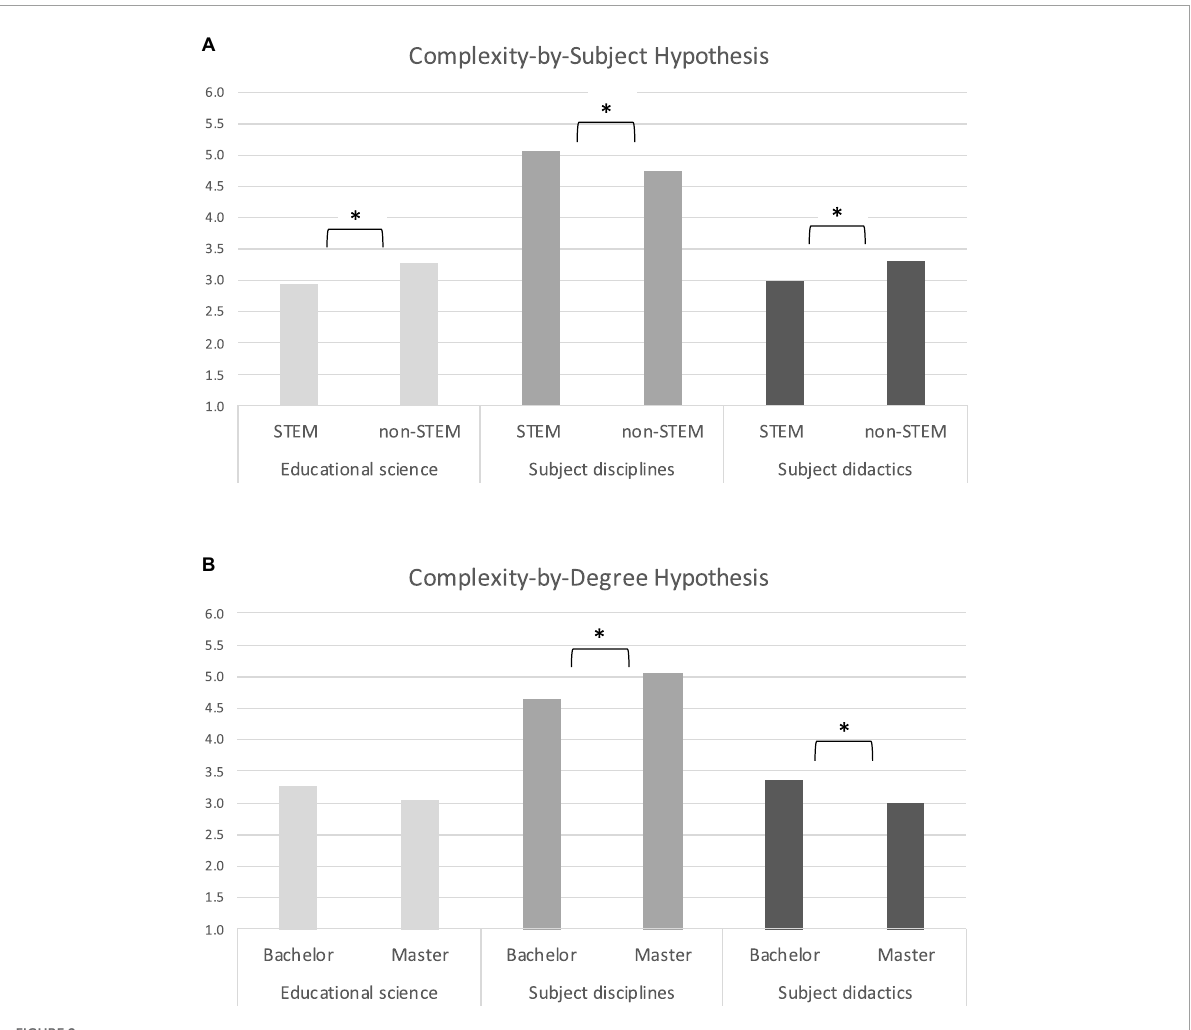
FIGURE2 Interaction effects: Complexity of the disciplines as a function of subject and degree program (Sub-Stud 1). The figure displays beliefs about the complexity of the three disciplines among students with a STEM subject (STEM) versus no STEM subjects (non-STEM; A ) and for students at the bachelor’s versus master’s level (B) . ∗ p < 0.05 in the simple effects